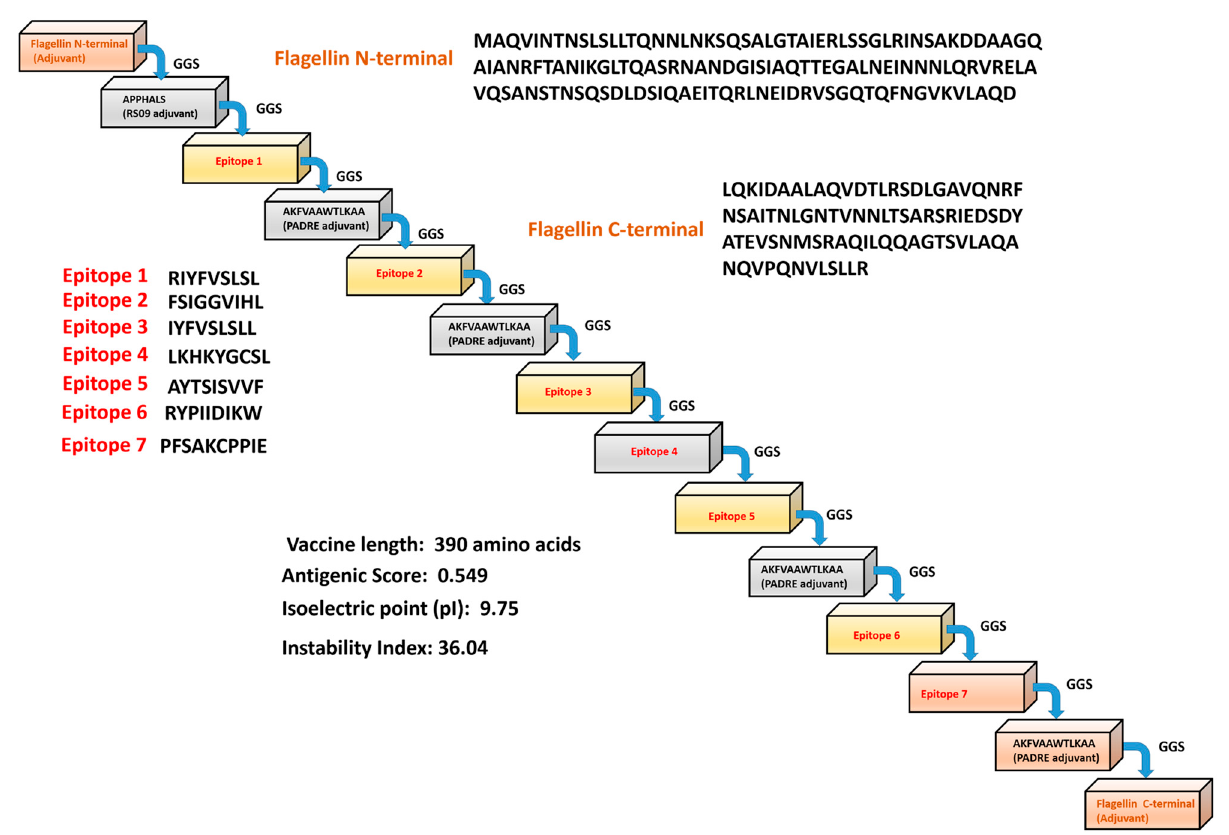
Figure 1. Scheme of the predicted monkeypox multi-epitope vaccine (MPXV-MEV) construct.